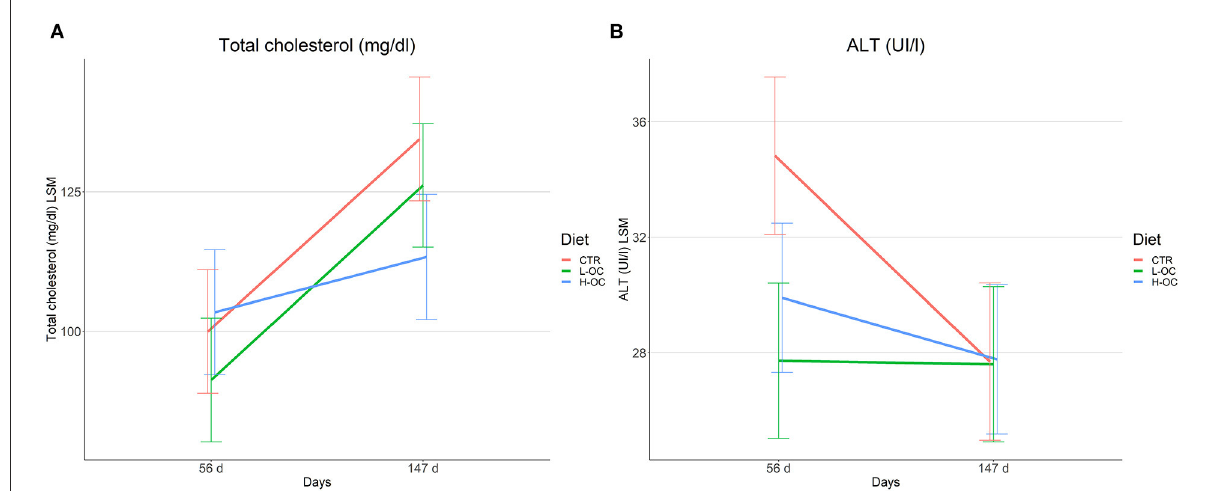
FIGURE2 Significant effect of the diet x time interaction on total cholesterol (A) and ALT (B) . The parameters’ least square mean (LSM) and standard error are represented for both the sampling times (56 and 147 days) and all the groups with different olive cake inclusions, namely control (CTR, 0%), Low-olive cake (L-OC, 10%), and High-olive cake (H-OC, 15%)